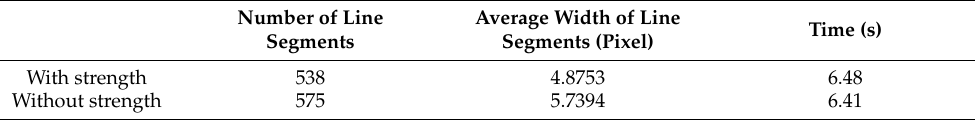
Table 3. Comparison of results with and without gradient